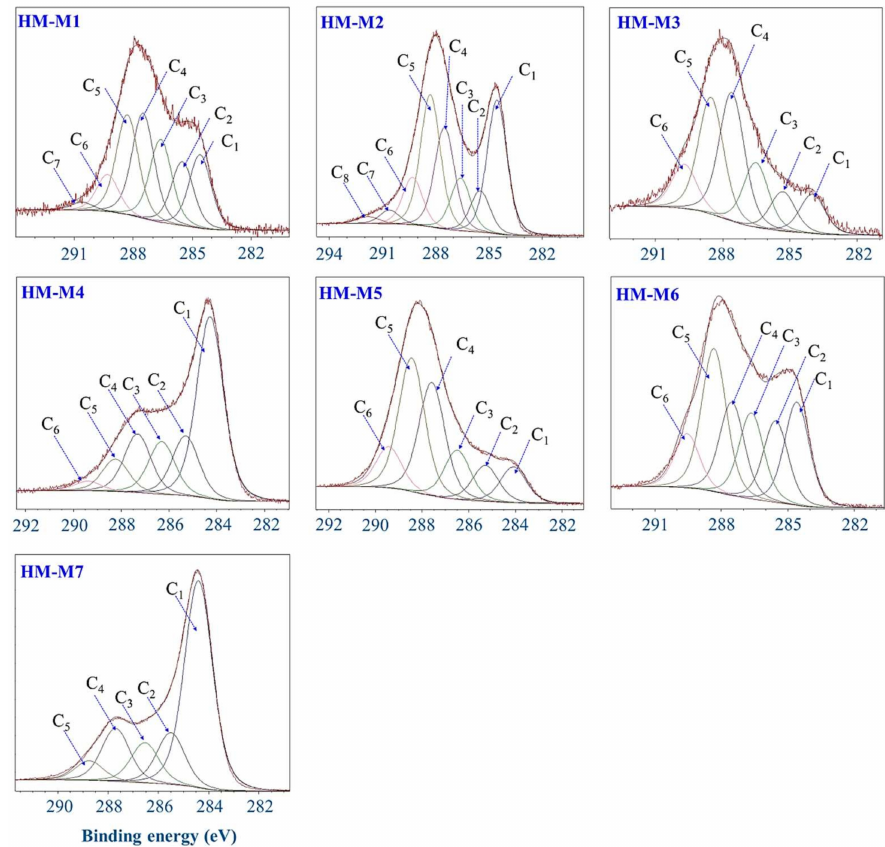
Figure 7. Deconvolution of C1s X-ray photoelectron spectroscopy (XPS) spectra of the seven humins (HMs). Table 4. Peak assignment in C1s X-ray photoelectron spectroscopy (XPS) spectra of the seven HMs. Peak Assignment and Area Percentage Humin